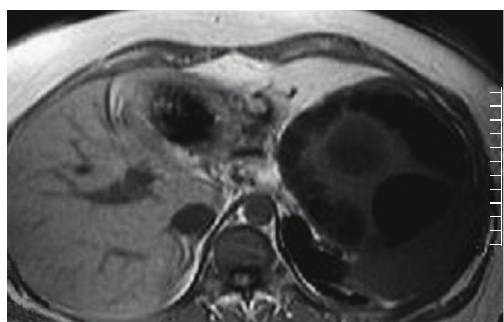
Figure 3: AxialnoncontrastT1-weighted MRI showsmultivesicular splenic cyst with low-signal-intensity.